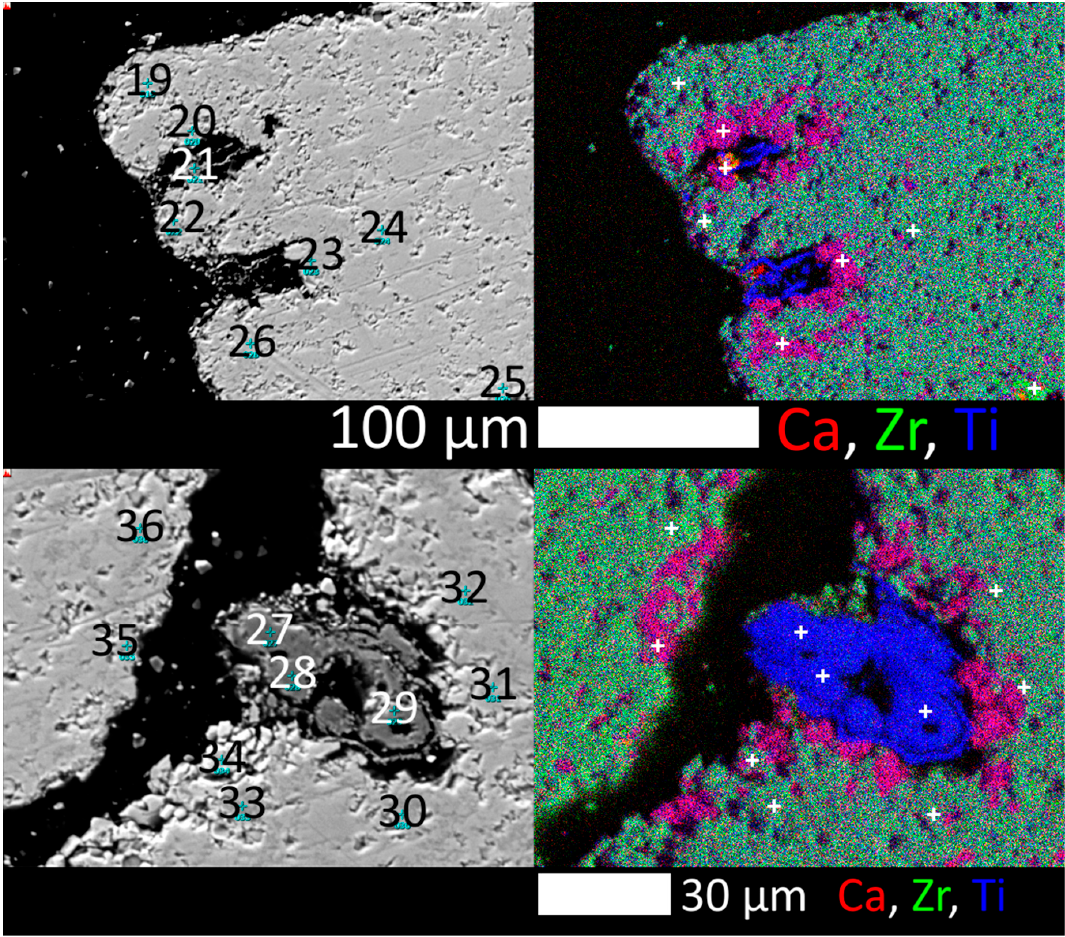
Figure 2. Rutile inclusions within zirconolite grains surrounded by perovskite. Left : backscattered electron (BSE) images, right : element map.